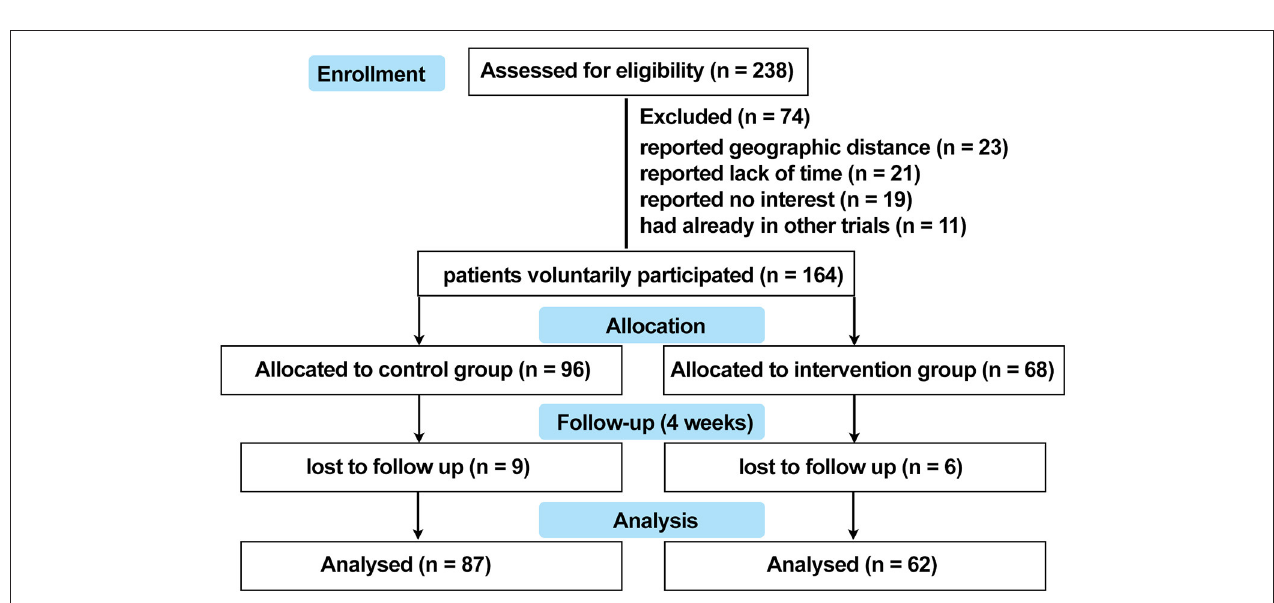
FIGURE 2 | Flow chart to show cohort